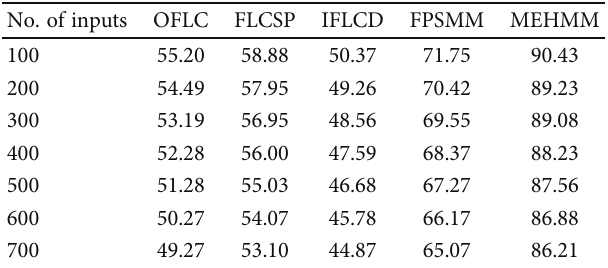
Table 6: Sensitivity to random light.